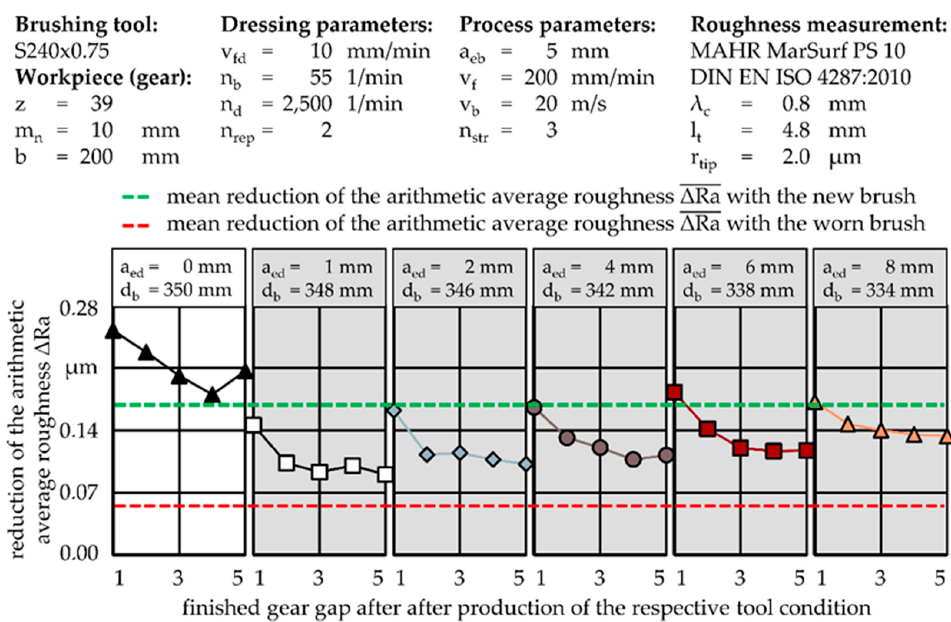
Figure 16. Reduction in the arithmetic average roughness Δ Ra using a dressed brush with different dressing infeeds a ed compared to a new and worn ‐ out brushing tool.